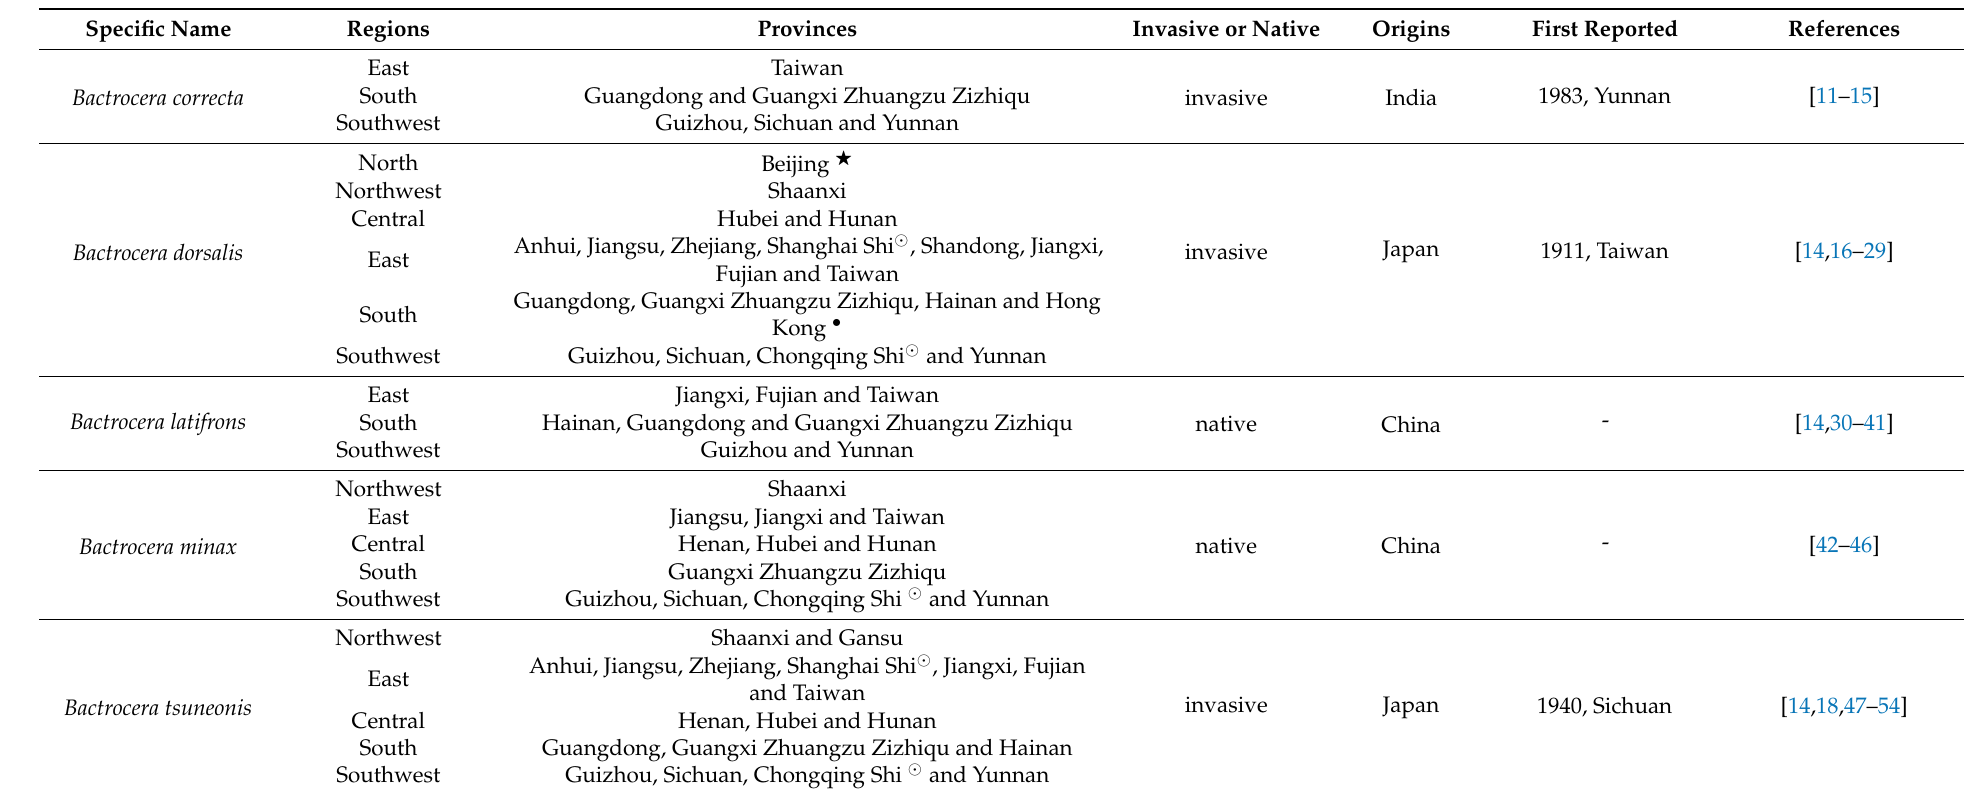
Table 1. Distribution of tephritid fruit flies (Diptera: Tephritidae) in China (based on the provincial